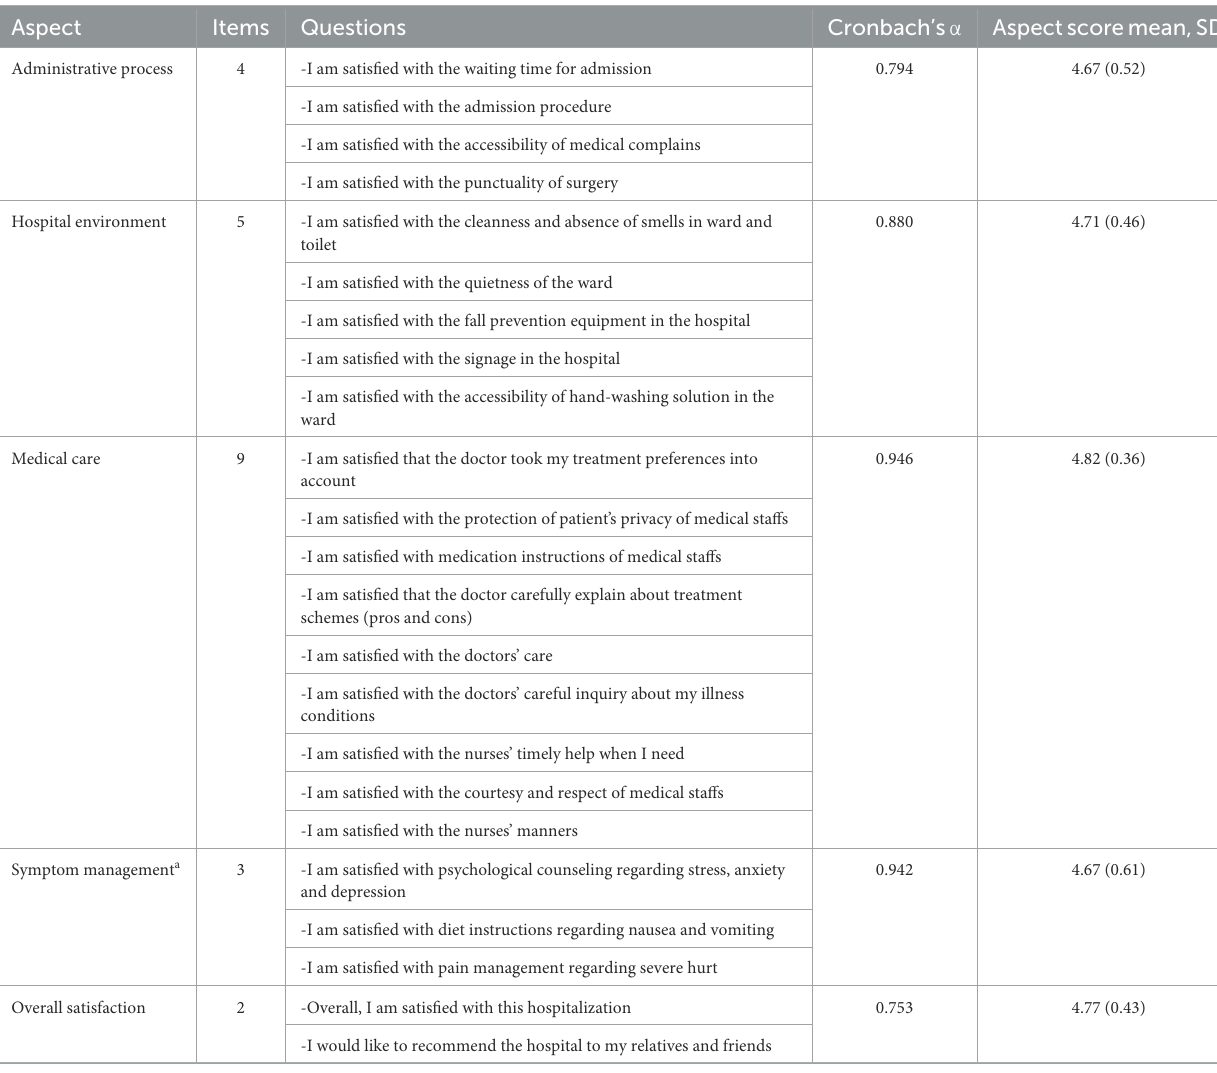
TABLE 1 Patient satisfaction, internal consistency, and average aspect